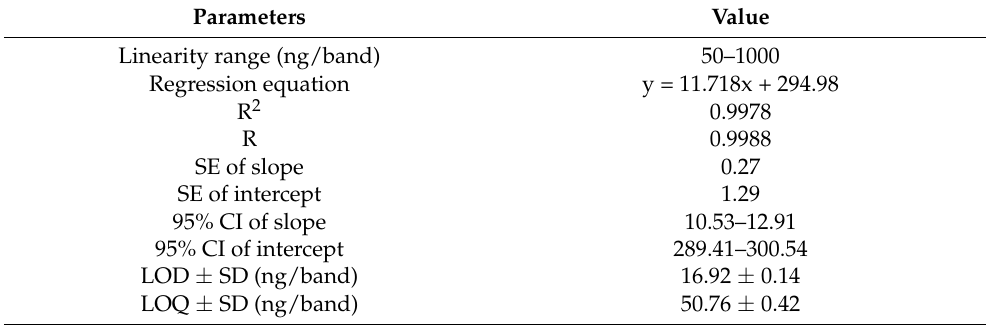
Table 1. Resulting data for the linearity of cordycepin (CDN) for current protocol (mean ± SD; n = 6).